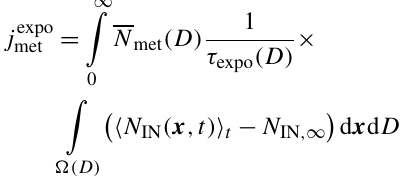
stant of proportionality being referred to as C expo